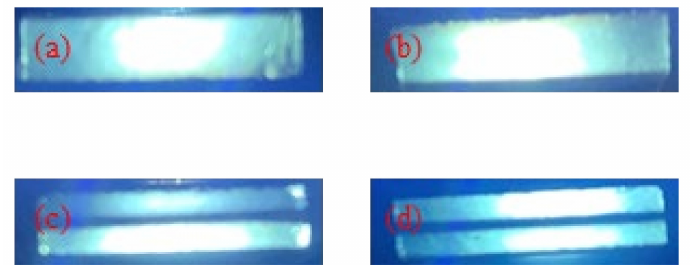
Figure 6. The cross-sectional view of the modified layer. ( a ) Sample 1 with the surface after wire cutting. ( b ) Sample 2 with the surface after polishing. ( c ) Sample 3 with the surface after mechanical polishing. ( d ) Sample 4 with the surface after chemical mechanical